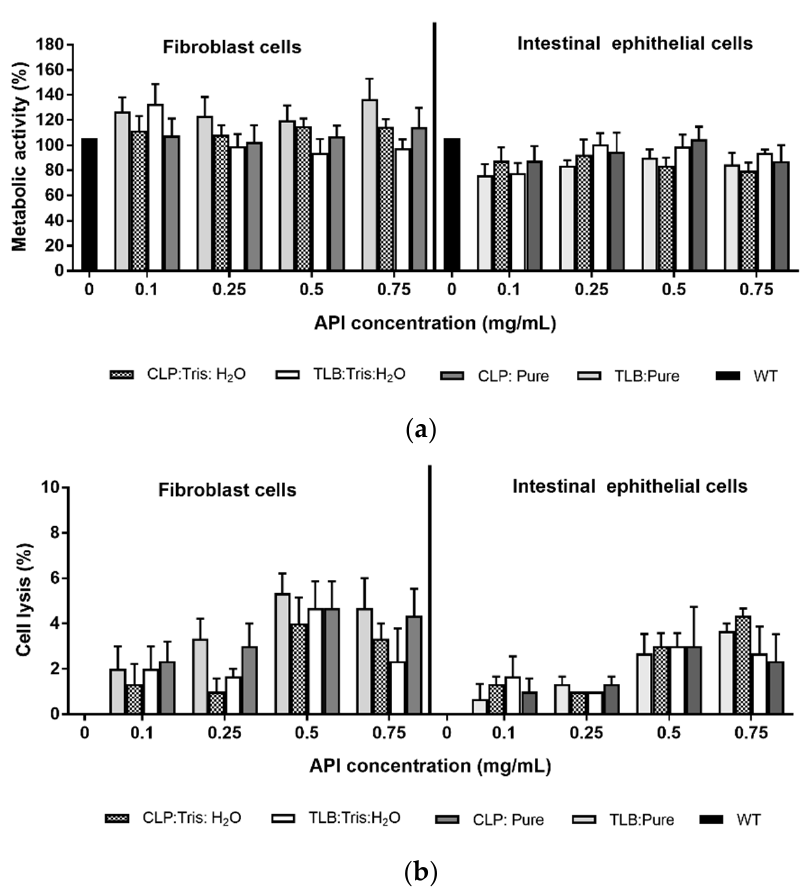
Figure 10. ( a ) Metabolic activity and ( b ) cell lysis for the THELES and crystalline APIs using fibroblast and intestinal epithelial cell lines. WT means wild−type, untreated cells (control).